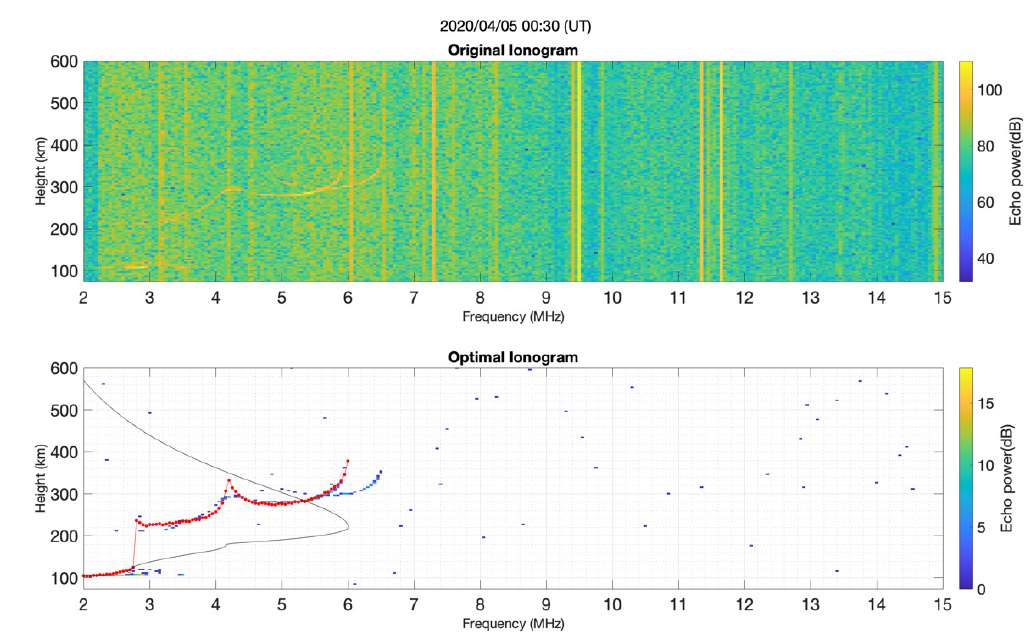
Figure 10. ( Top ) Original ionogram recorded on 05 April 2020 at 00:30 UT by the Chung-Li ionosonde; ( Bottom ) identified O-wave (red curve), X-wave (blue curve), and the corresponding electron density profile (black curve) made with the autoscaling algorithm.